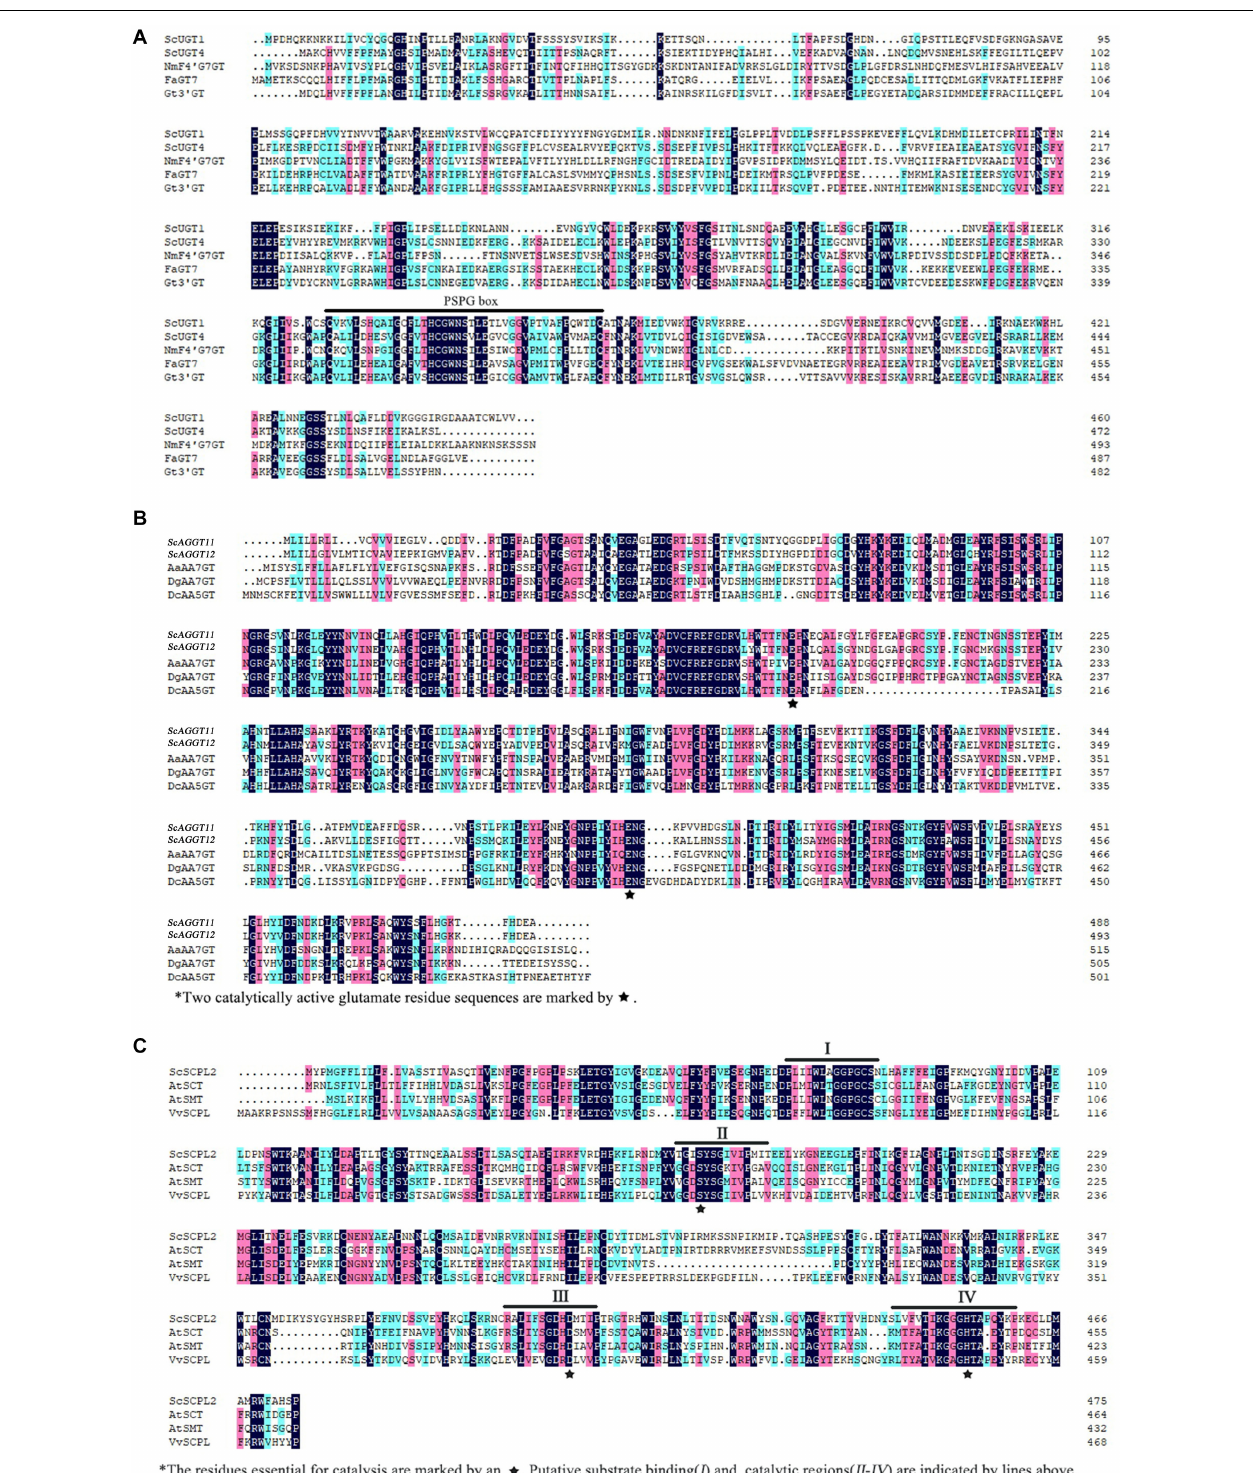
FIGURE 7 | Multiple alignments of amino acid sequences of ScUGT1 , ScUGT4 , ScBGLU11 , ScBGLU12 , and ScSCPL2 . (A) Sequence alignment of ScUGT1 and ScUGT4 ( Senecio cruentus ), NmF4 (cid:48) G7GT ( Nemophila menziesii ), FaGT7 ( Fragaria ananassa ), and Gt3 (cid:48) GT ( Gentiana triflora ). (B) Sequence alignment of ScAGGT11 and ScAGGT12 ( Senecio cruentus ), AaAA7GT ( Agapanthus africanus ), DgAA7GT ( Delphinium grandiflorum ), and DcAA5GT ( Dianthus caryophyllus ). (C) Sequence alignment of ScSCPL2 ( Senecio cruentus ), AtSCT (Arabidopsis thaliana) , AtSMT ( Arabidopsis thaliana ), and VvSCPL ( Vitis vinifera ).